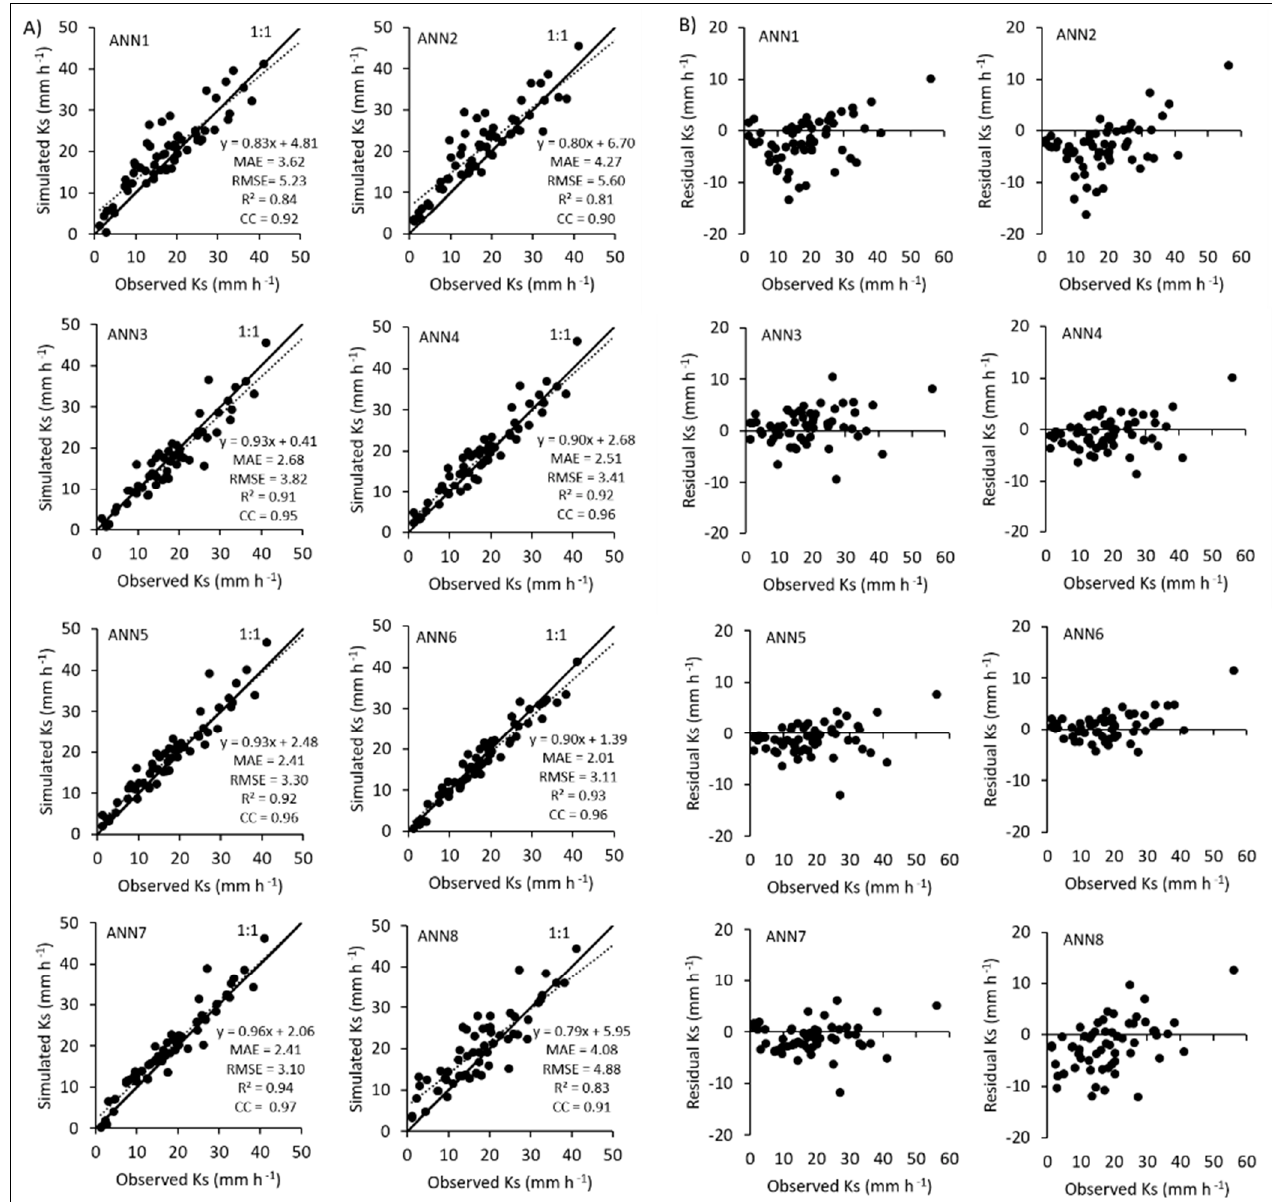
Figure 5. Scatter and residual plots of the ANN model with eight combinations of soil input data.